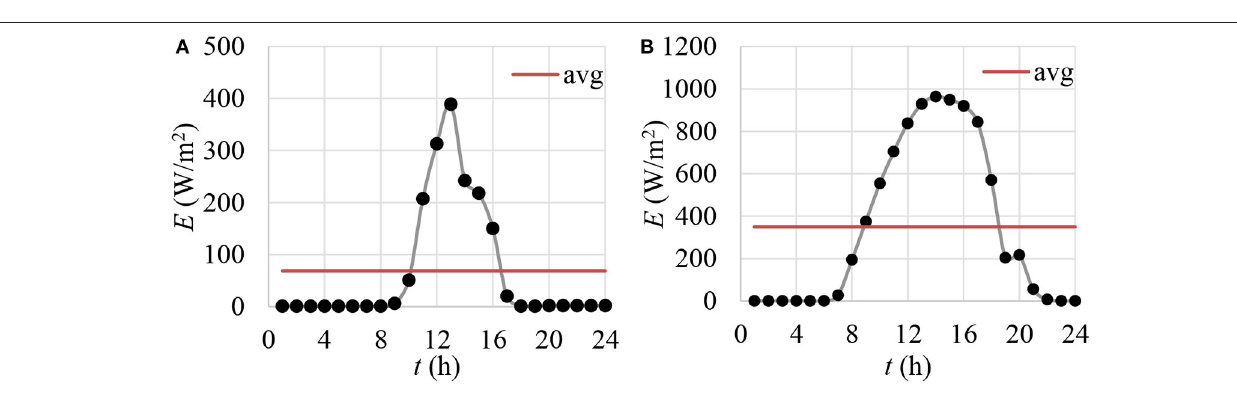
FIGURE 5 | Hourly and average irradiation for (A) typical day in winter (1st January 2019) and (B) typical day in summer (1st July